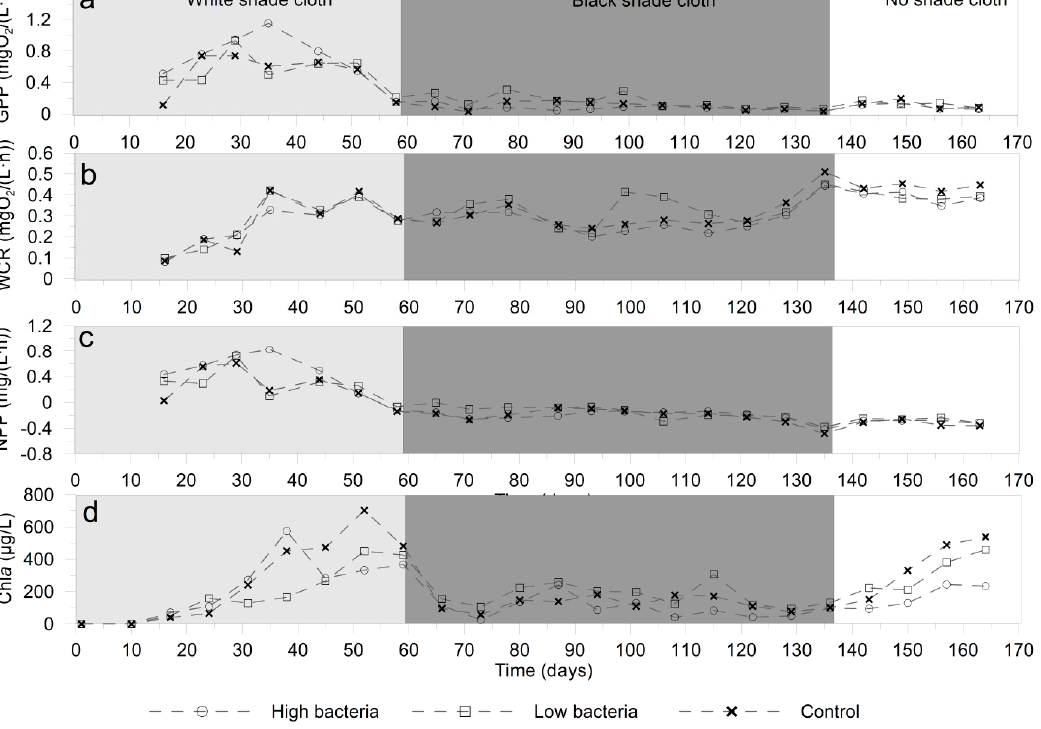
Figure 4. Evolution of microbial activity, ( a ) gross primary production, ( b ) water column respiration, ( c ) net primary production and ( d ) chlorophyll a . Each data represents the average of the three experimental units for high bacteria treatment (2.8 × 10 4 cfu/mL), low bacteria treatment (2.8 × 10 3 cfu/mL) and control treatment.